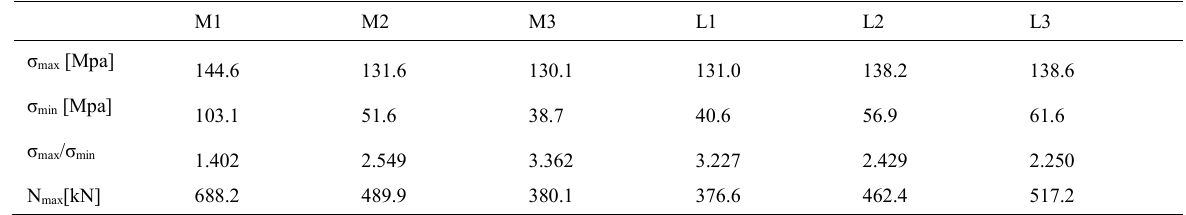
Table 5: Compressive stress σ max ,σ min and failure load N max